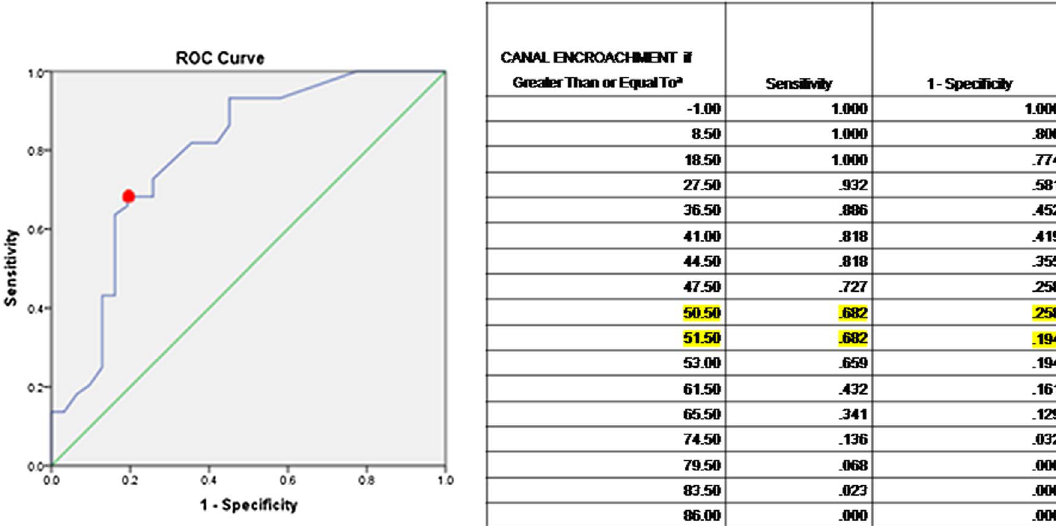
Figure 4. Receiver operating characteristic (ROC) curve to fi nd the threshold value of canal encroachment above which it had the maximum association with neurological de fi cit. Y -axis (sensitivity) represents true positive while X -axis (1-speci fi city) represents false positives. The threshold value is represented by red